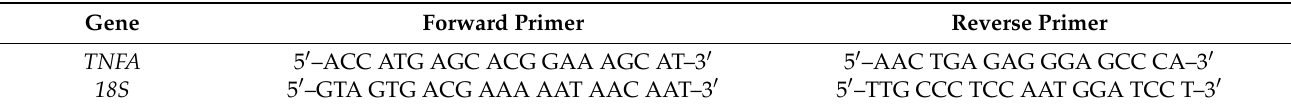
Table 2. Pairs of primers used to amplify rat genes by RT-qPCR.